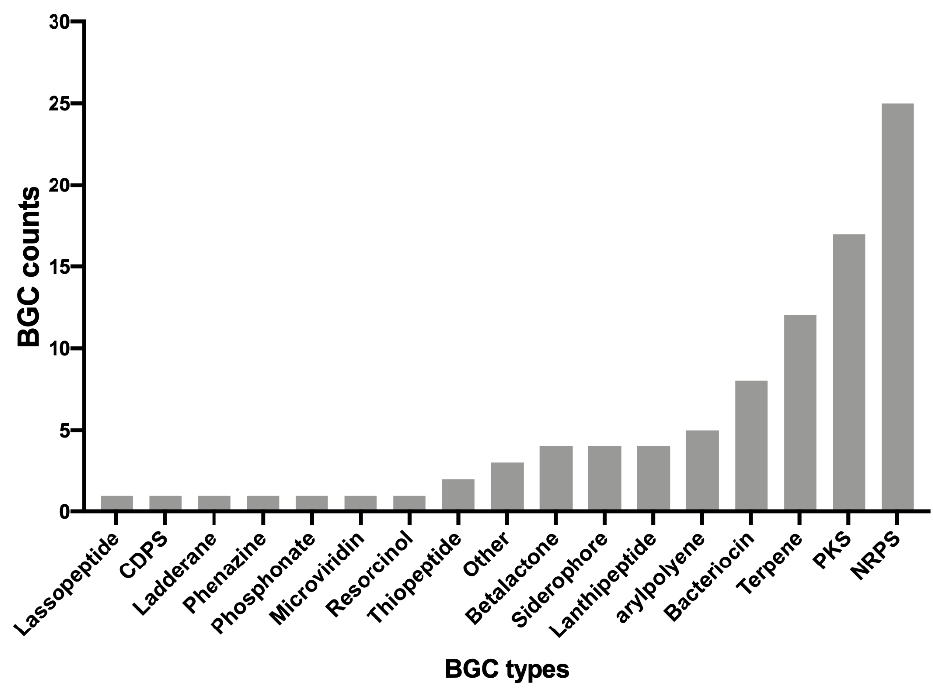
Figure 3. Diversity of BGC types identified in the genomes of the bacterial isolates using AntiSMASH.